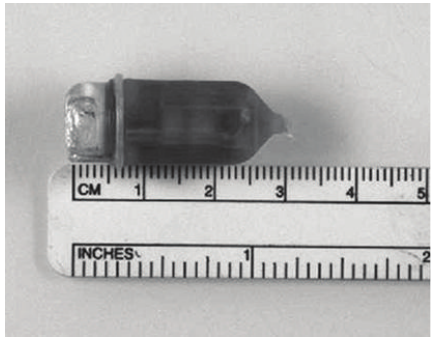
Figure 1: A SmartPill pH.p wireless motility